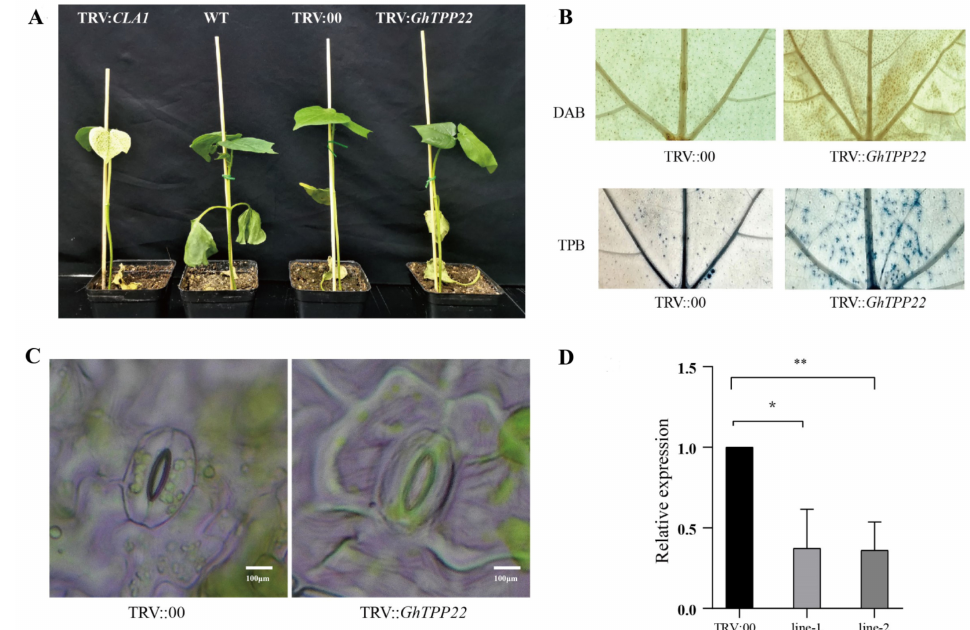
Figure 9. Functional study of GhTPP22 . ( A ) Growth and development of TRV:: CLA1 , WT, TRV::00 and TRV:: GhTPP22 plants under drought stress; ( B ) DAB and trypan blue (represented in the figure as TPB) staining of TRV::00 and TRV:: GhTPP22 leaves; ( C ) The stomatal closure status of TRV::00 and TRV:: GhTPP22 under drought conditions; ( D ) qPCR verification results; the error bars show the standard deviations from three technical replicates, *and ** indicate the significant differences between the control samples (TRV::00) and the samples collected from TRV::GhTPP22 plants, as determined by Student’s t -test, at p -values ≤ 0.05 and ≤ 0.01,